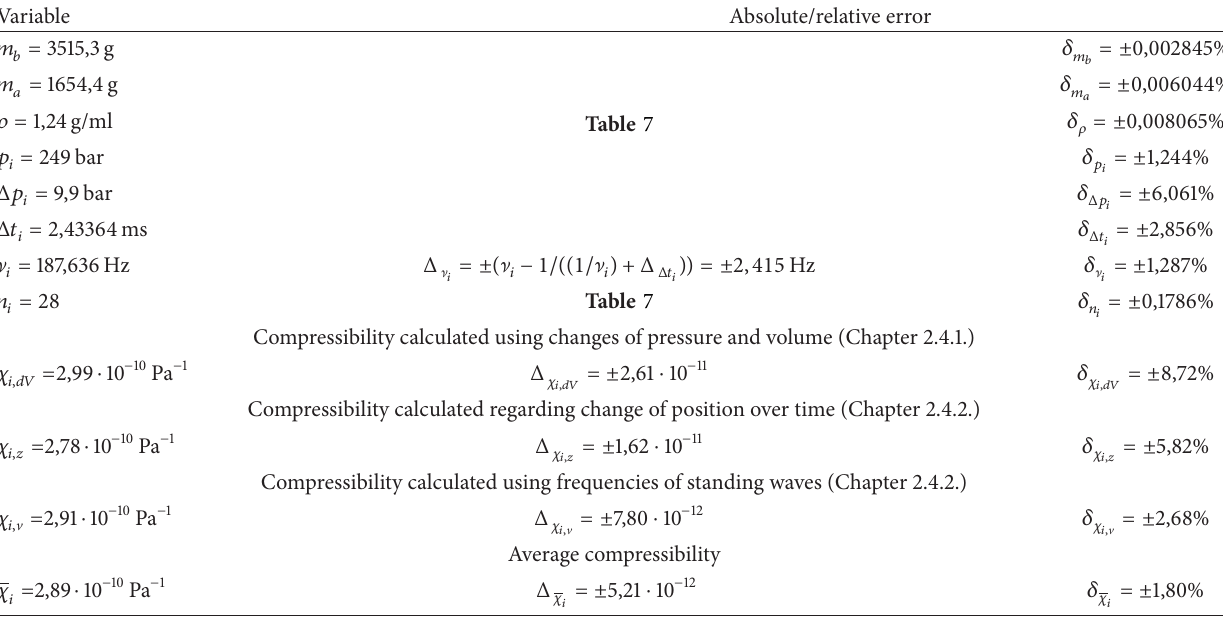
Table 8: Absolute and relative errors at one measurement